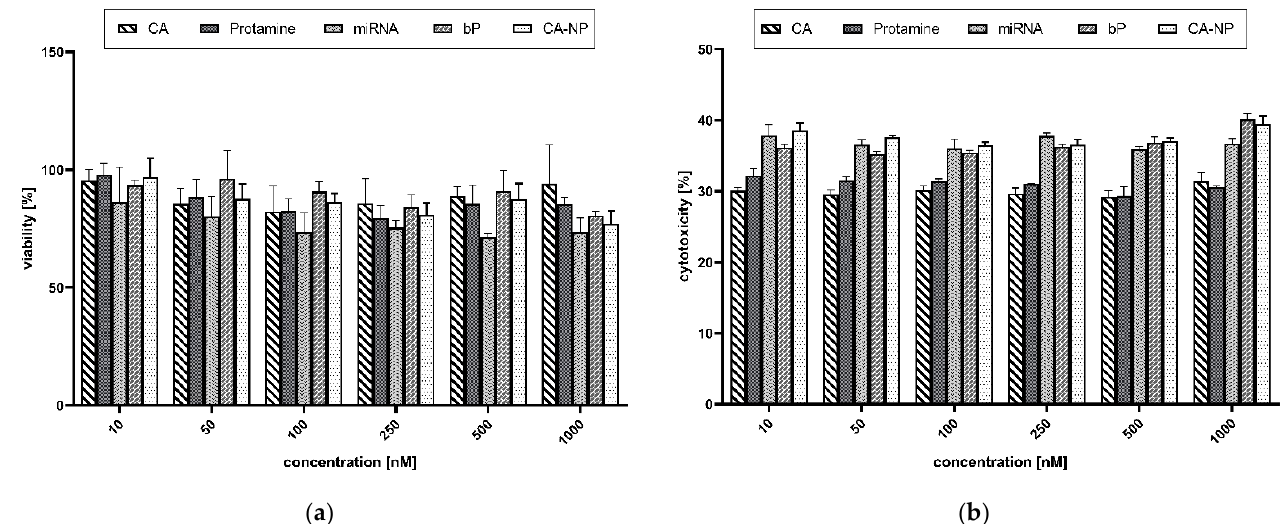
Figure 8. ( a ) MTS viability assay. ( b ) LDH cytotoxicity assay. Data are expressed as mean values ( n = 3) ± standard deviation. Here, 100% viability was correlated with untreated cells, while 100% cytotoxicity was correlated with cells treated with a lysis buffer. CA: citric acid; miRNA: microRNA (non-targeting control microRNA); bP: binary proticles; CA-NP: citric acid-supplemented proticles.